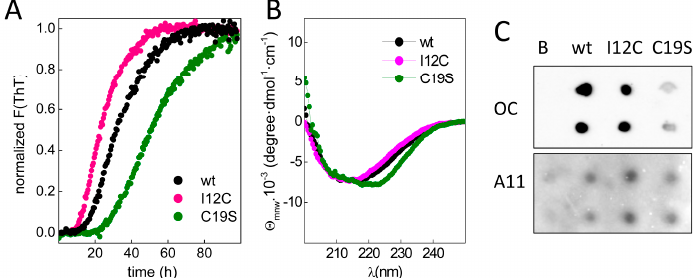
Figure 3. Amyloid aggregation of Gad m 1 chains. ( A ) Kinetics of amyloid aggregation monitored by thioflavin T (ThT) fluorescence. ( B ) CD spectra of Gad m 1 aggregates isolated by ultracentrifugation. ( C ) Dot-blot analysis of the recognition of the aggregation reaction products by anti-amyloid fibril (OC) and anti-amyloid oligomer (A11) antibodies. The label B corresponds to the Ca 2+ -bound Gad m 1 wt monomer.